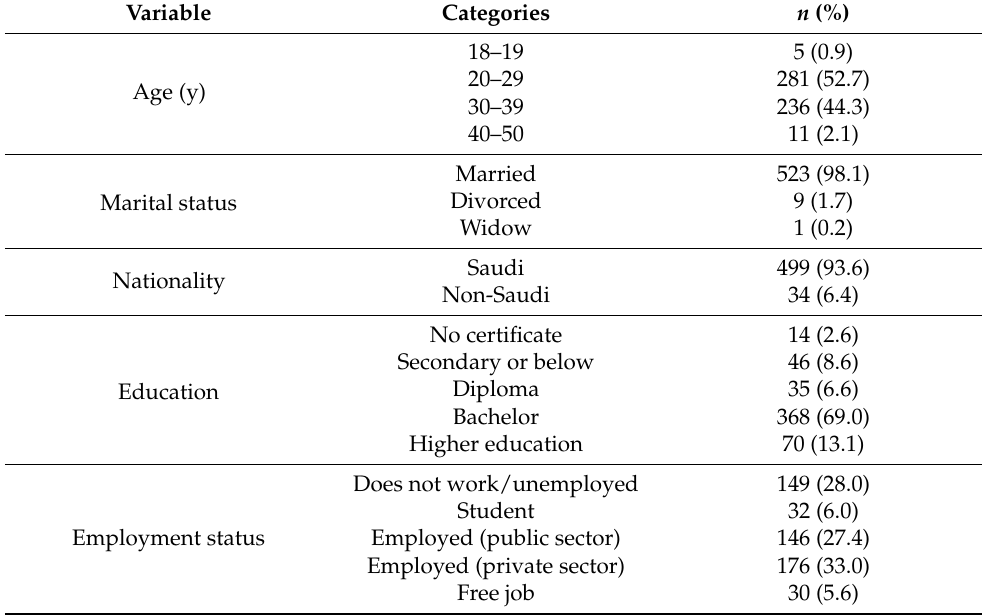
Table 1. Sample Characteristics and